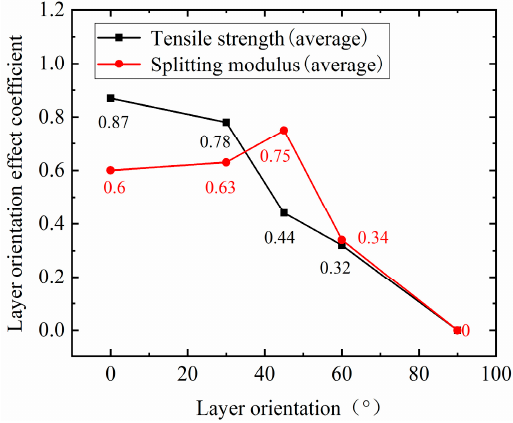
Figure 8. Layer orientation effect coefficient.